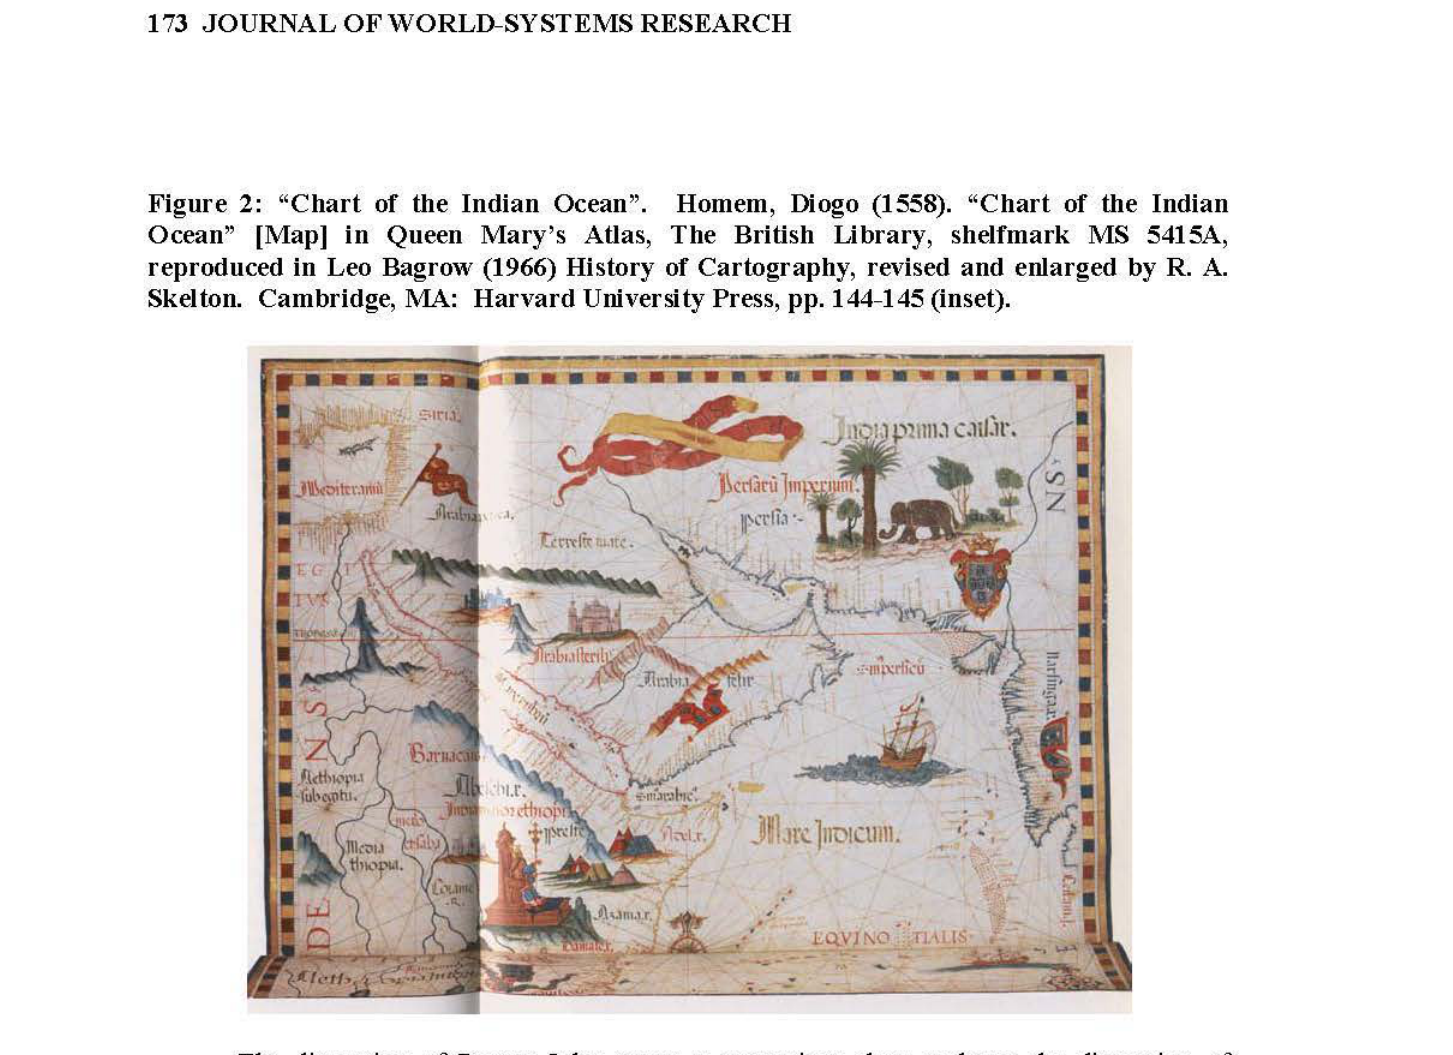
Figure 2: "Chart of the Indian Ocean". Homem, Diogo (1558). "Chart of the Indian Ocean" [Map] in Queen Mary's Atlas, The British Library, shelfmark MS 5415A, reproduced in Leo Bagrow (1966) History of Cartography, revised and enlarged by R. A. Skelton. Cambridge, MA: Harvard University Press, pp. 144-145